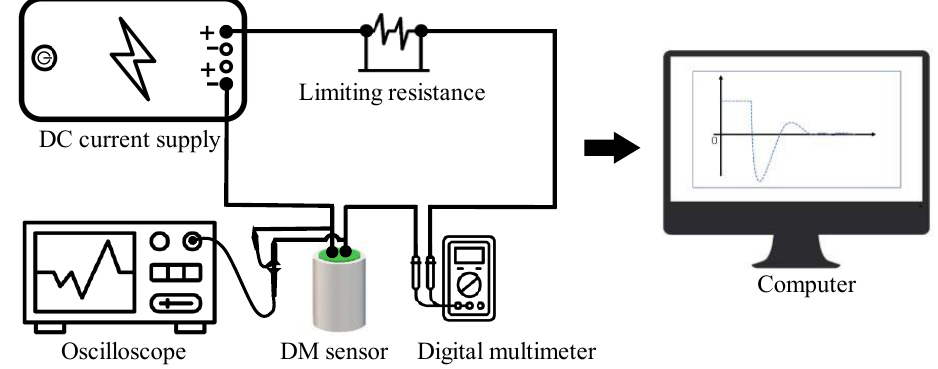
Figure 17. Principle diagram of DC excitation method.